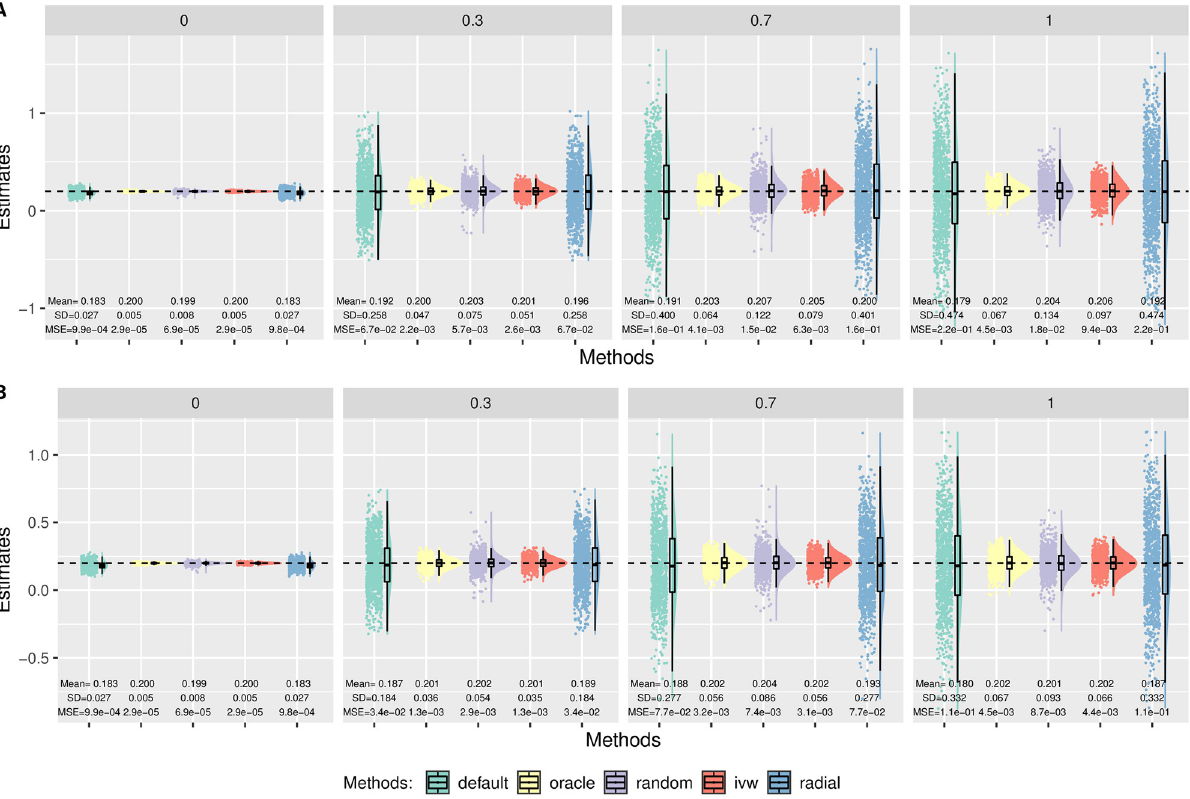
Fig 3. Simulation (a) results with n = 100 000, θ = 0.2, m = 100. Empirical distributions of the estimates of the causal effect θ by the methods. Each column corresponds to 0%, 30%, 70% or 100% invalid IVs. A: Directional pleiotropy. B: Balanced pleiotropy.